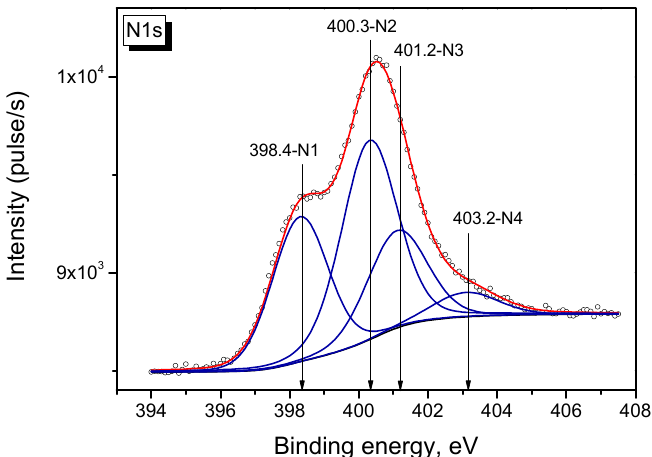
Figure 6. Deconvolution of N1s XPS spectrum of N-graphene with deconvolution to individual components.